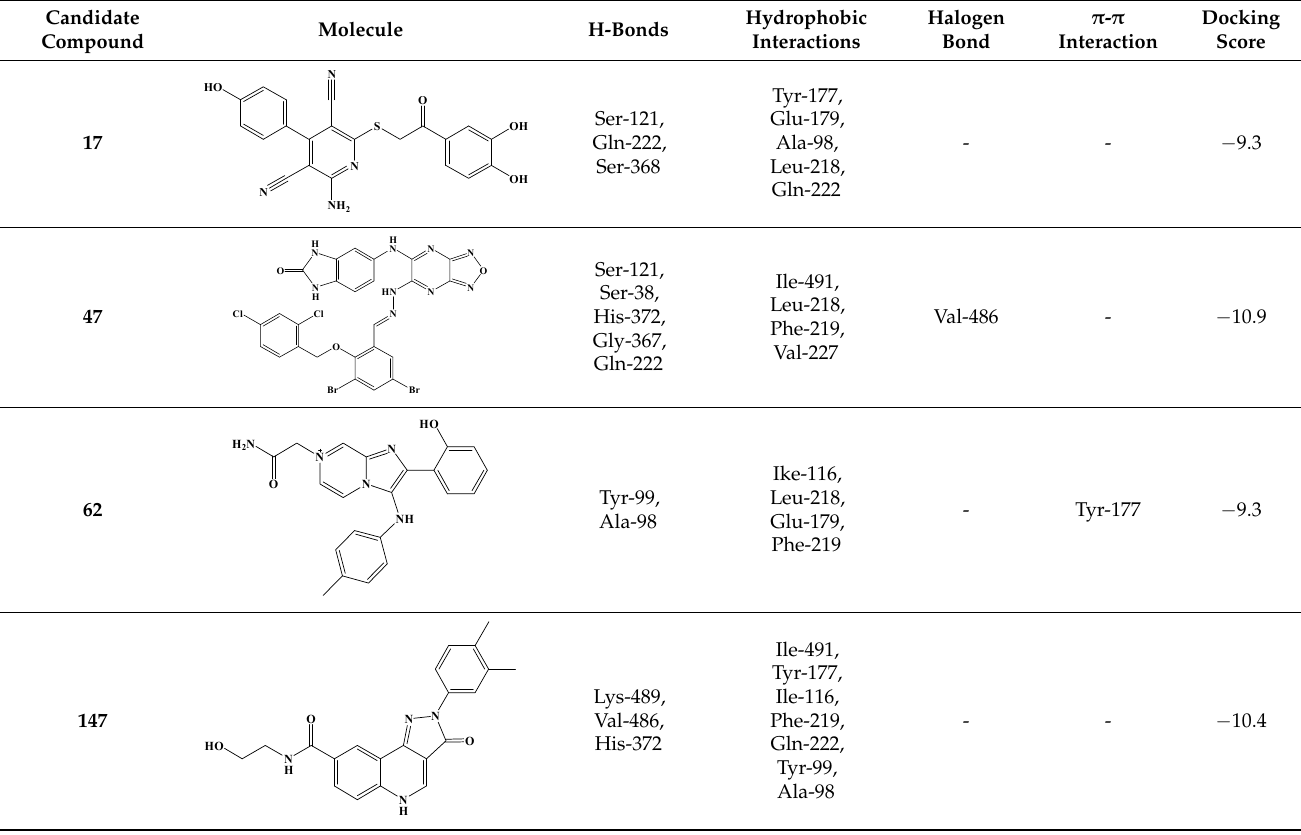
Figure 3. Dose–response curves of candidate compounds. ( a – d ) represent the dose–response curve of compounds 17 , 47 , 62 and 147 . Table 1. List of molecules on the basis of docking score (kcal/mol) and interacting residues of Pf PMV with four candidate compounds.